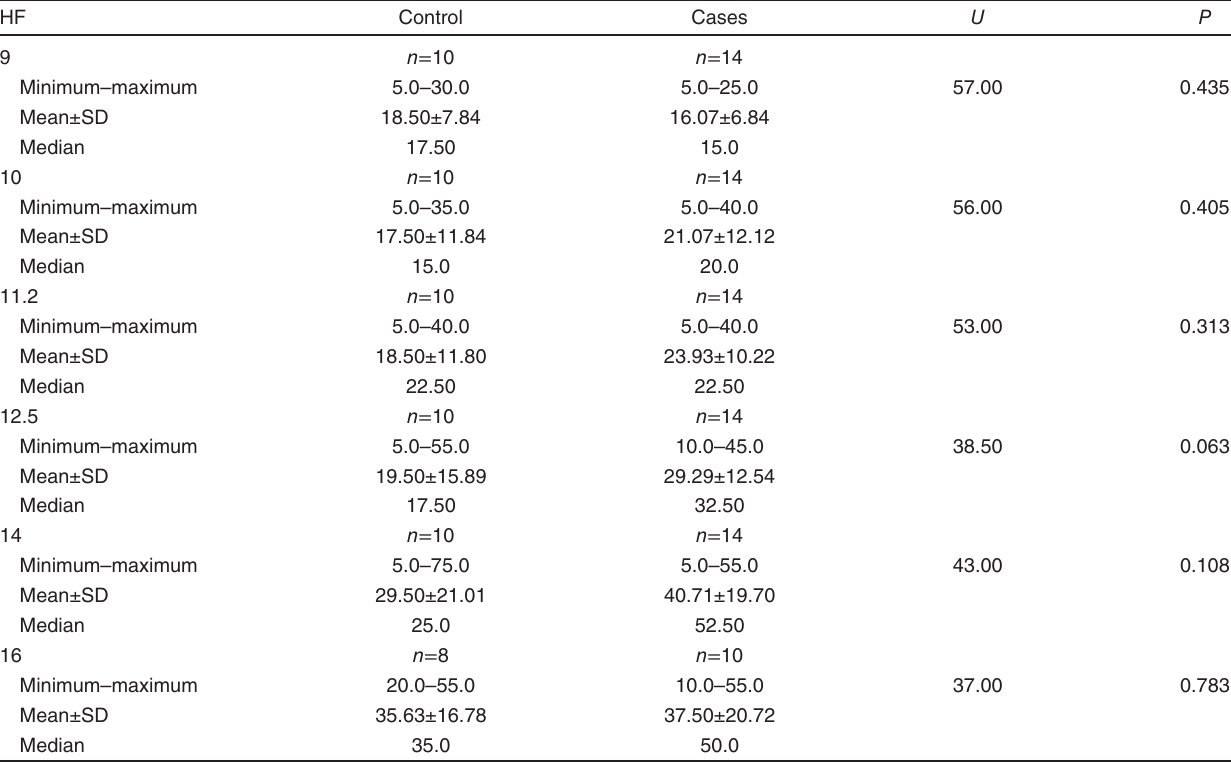
Table 5 High frequency audiometry thresholds in the two studied groups at age from 31 to 40 years